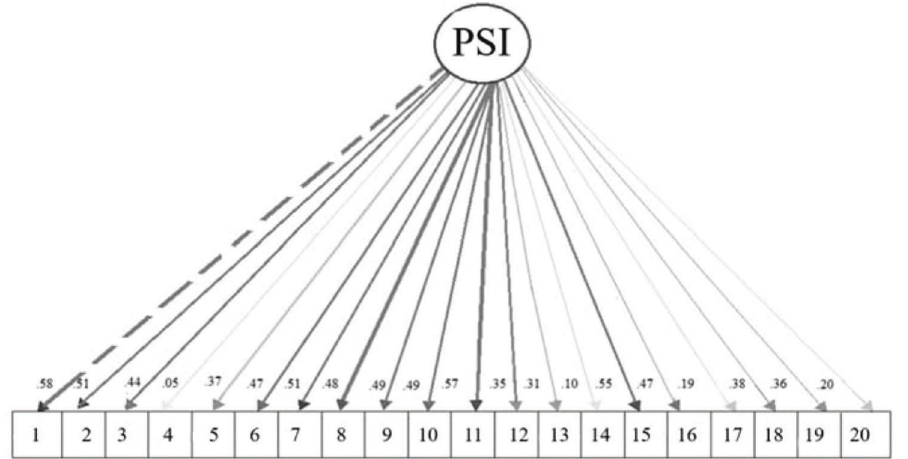
Figure 1 - PSI factorial structure. The circle represents the construct (latent variable) and the squares constitute the observable variables (instrument items); the denser the lines, the more representative the item (higher factor load) (24). PSI, Prefrontal Systems